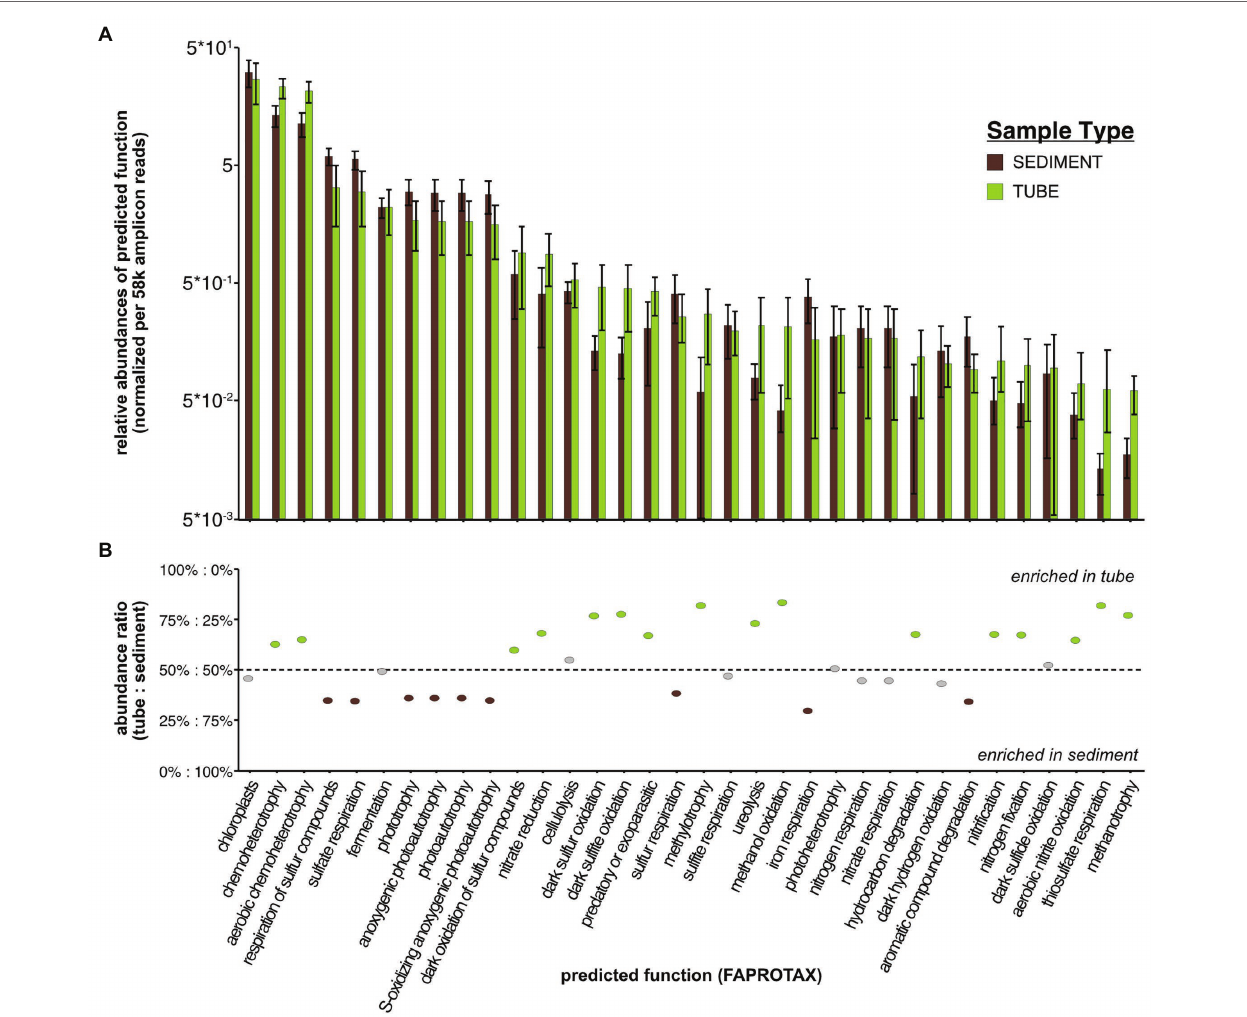
FIGURE 4 | (A) Distribution of normalized abundances of predicted functions ( via FAPROTAX) for sediment and tube microbial samples. (B) Ratio of abundance between tubes and sediments for each inferred functional group determined by FAPROTAX